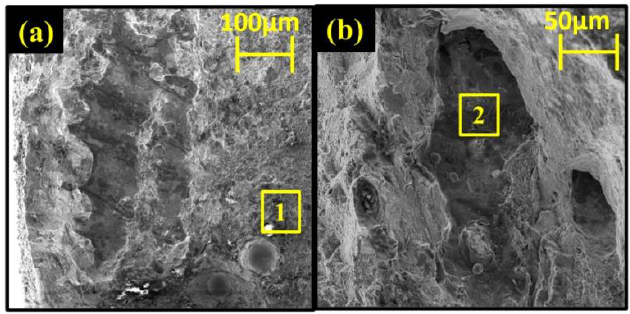
Figure 19: SEM fractography of EBW’ed sample 16A (209.6 J/mm) that fractured in the base metal; (a) Spherical pores (label 1) and (b) Brittle carbide phases (label 2)